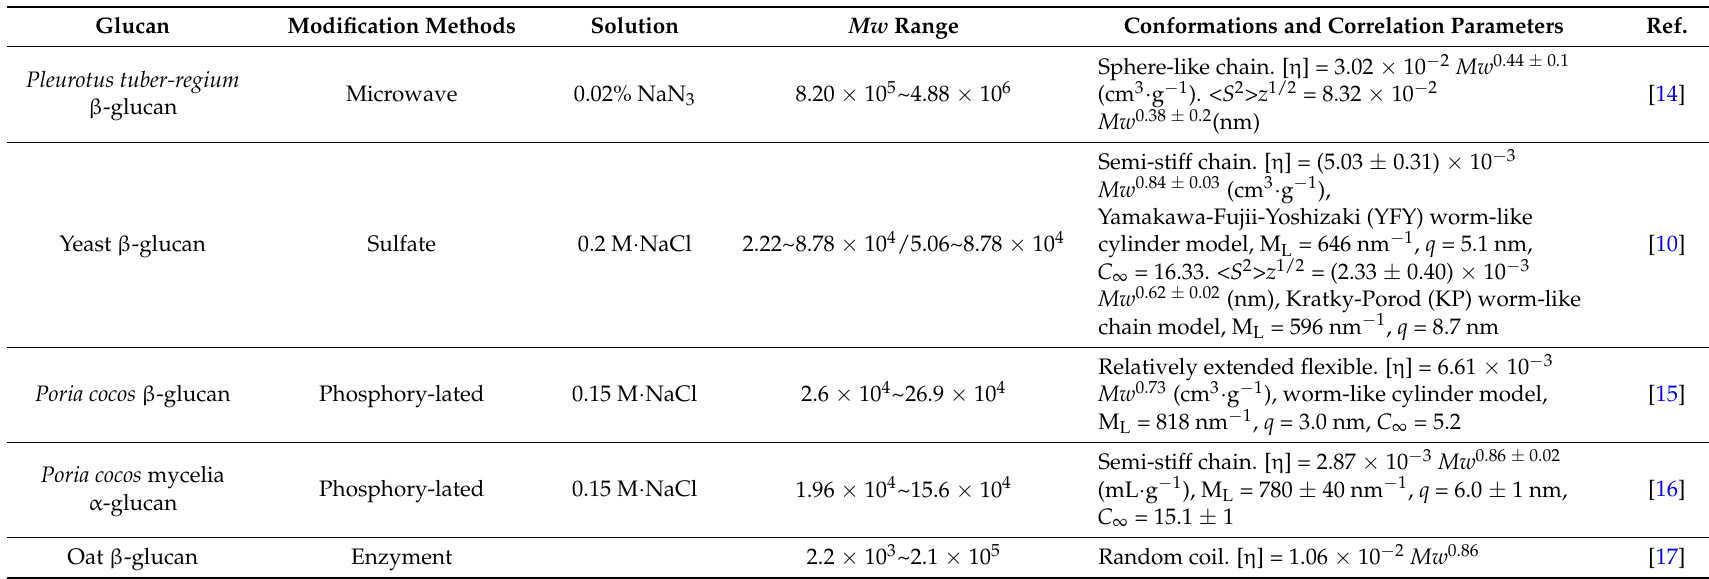
Table 1. Conformations and correlation parameters of modified β